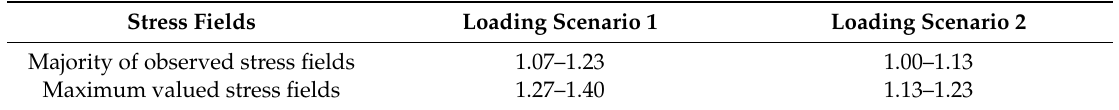
Table 4. Stress concentration factors ( K